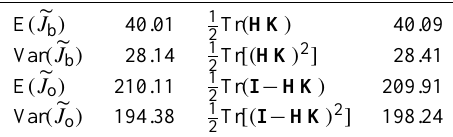
Fig. 3. Scatterplot of the values of the background cost function and the observation cost function at the minimum. Table 1. Comparison of the simulated optimal innovation method with the randomized trace estimation, following Eqs. (16), (17), (21), and (22).